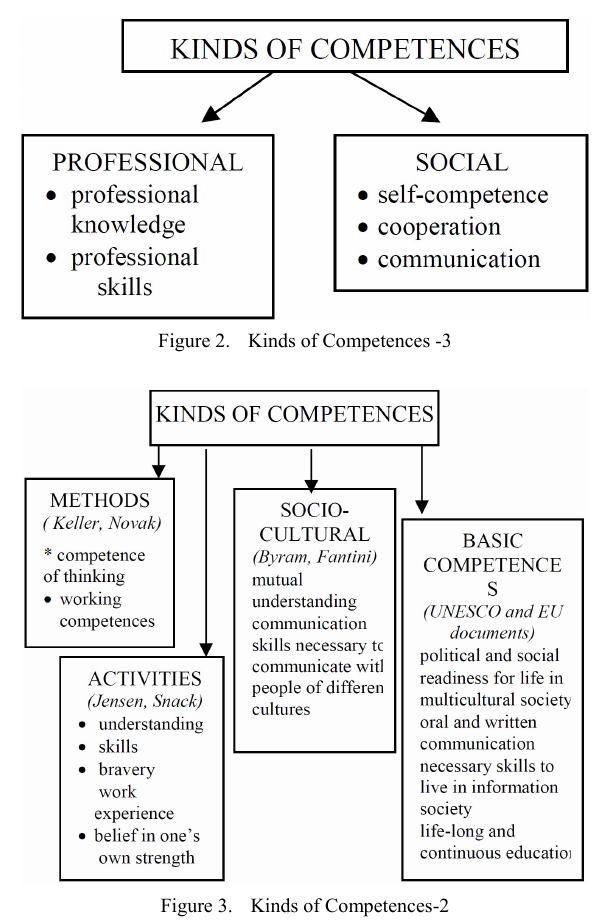
Figure 3. Kinds of